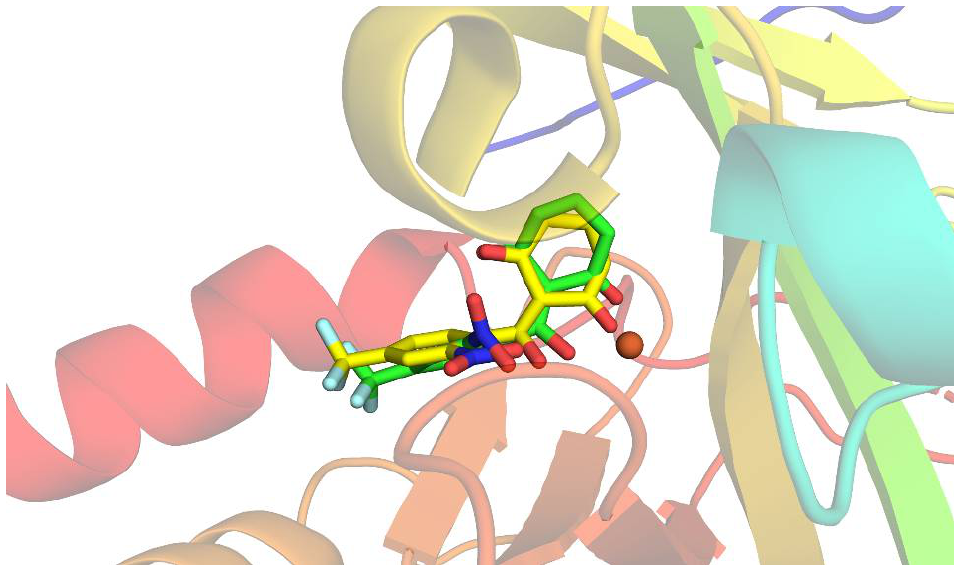
Figure 3. The structure obtained by redocking (yellow), overlapping the crystallographic structure (red) of HPPD complexed with NTBC.